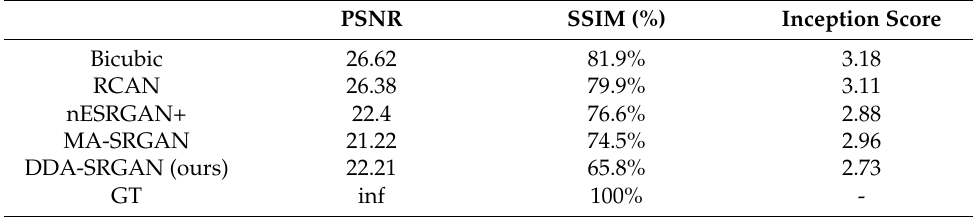
Table 7. The comparison of the proposed method with different SR models for face